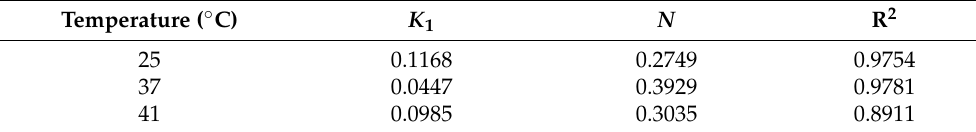
Table 1. Parameters of model 1 for the power ‐ law equation, a classical diffusion Fickian ‐ type.